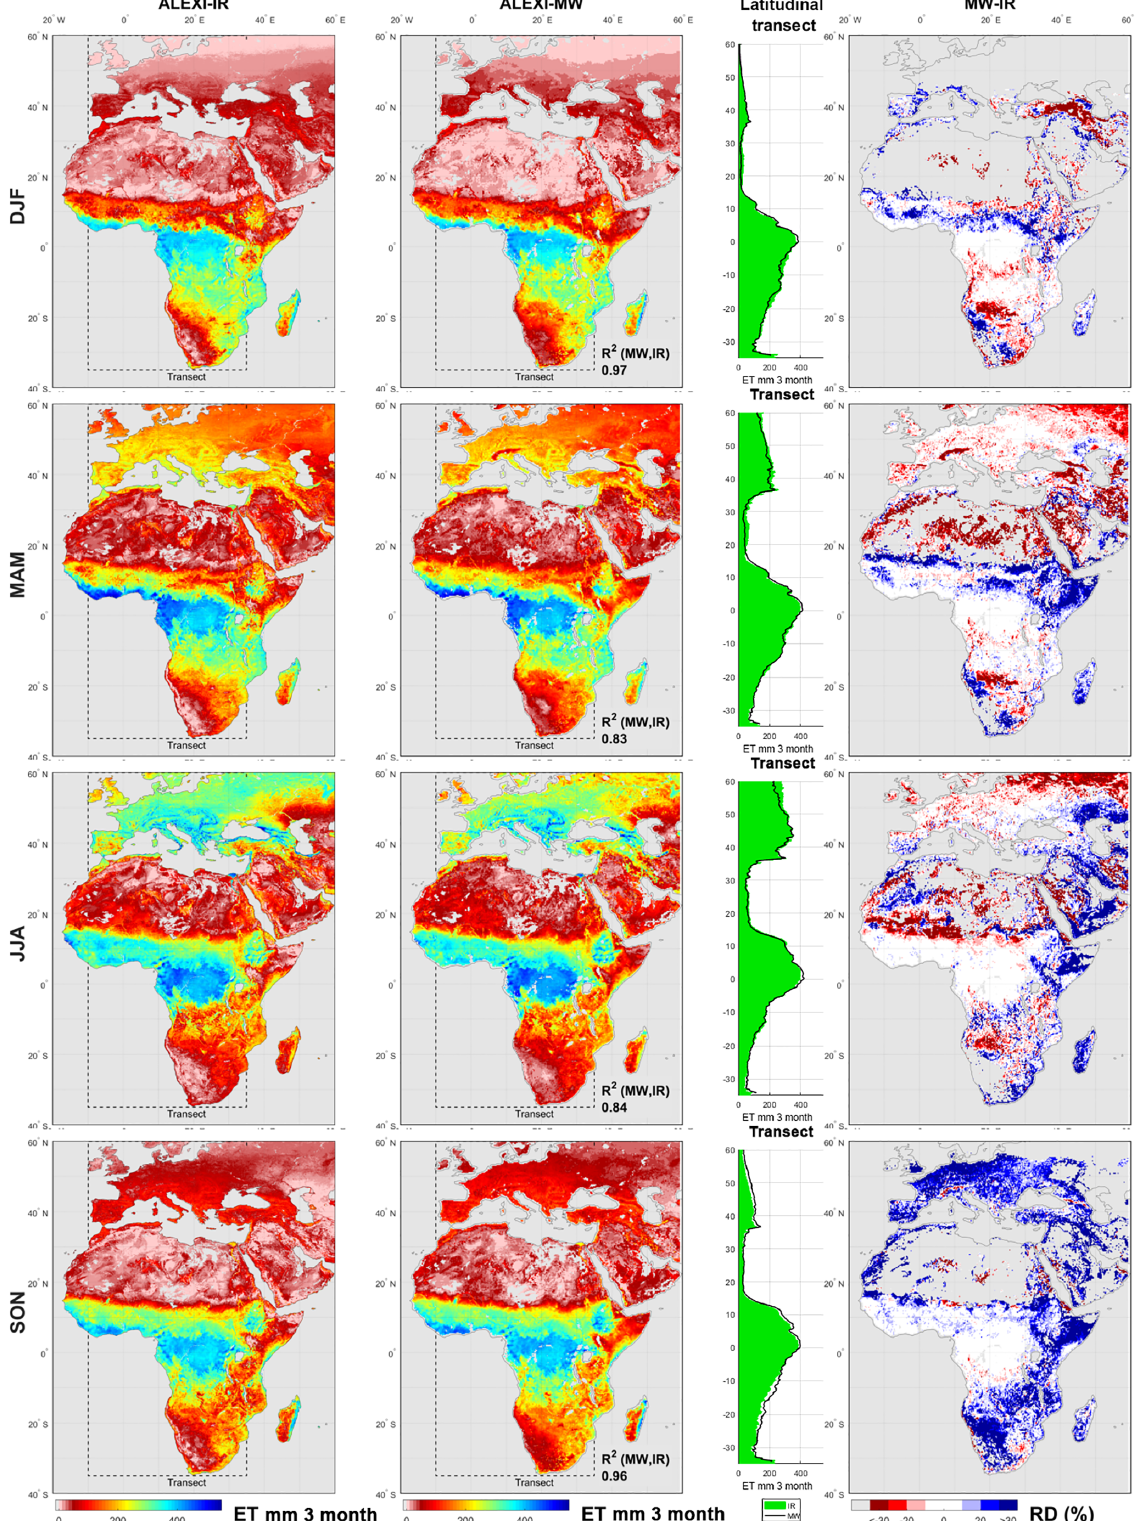
Figure 6. As Fig. 4, but now averaged by